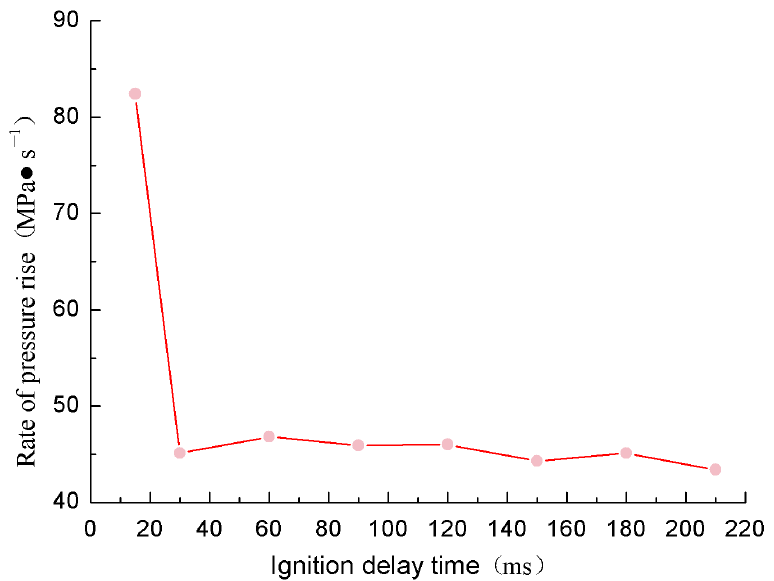
Figure 5. Correspondence between the maximum rate of pressure increase and ignition delay time.